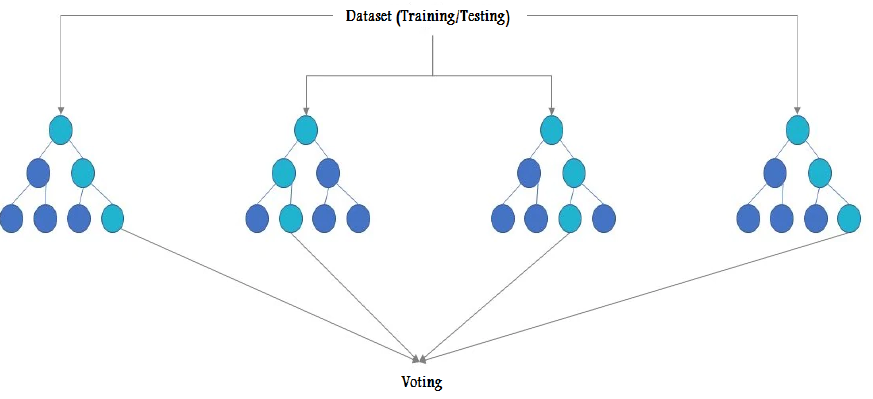
Fig. 5. Random Forest Functionality for Classification